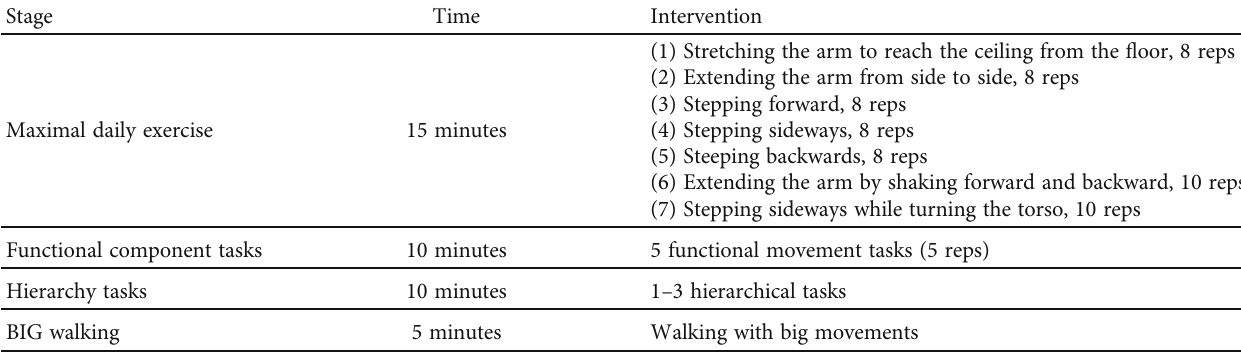
Table 1: Description of the Lee Silverman Voice Treatment-BIG (original protocol).